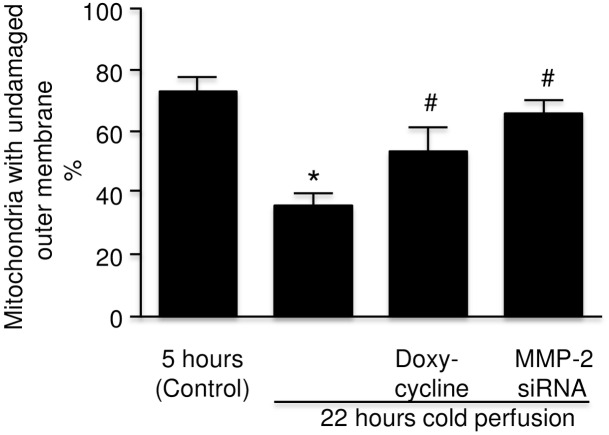
Level of undamaged mitochondria measured by the levels of cytochrome c oxidase activity in rat kidney tissue after initial flush and following 22 hours of machine cold perfusion with KPS-1, KPS-1 with doxycycline, and KPS-1 with MMP-2 siRNA (n = 4).Error bars represent Standard Error of the Mean (SEM). * p<0.05 compared to 0 hours using Student’s T test.# p<0.05 compared to 22 hours using Student’s T test.KPS-1 = Kidney Preservation Solution 1MMP = matrix metalloproteinase.